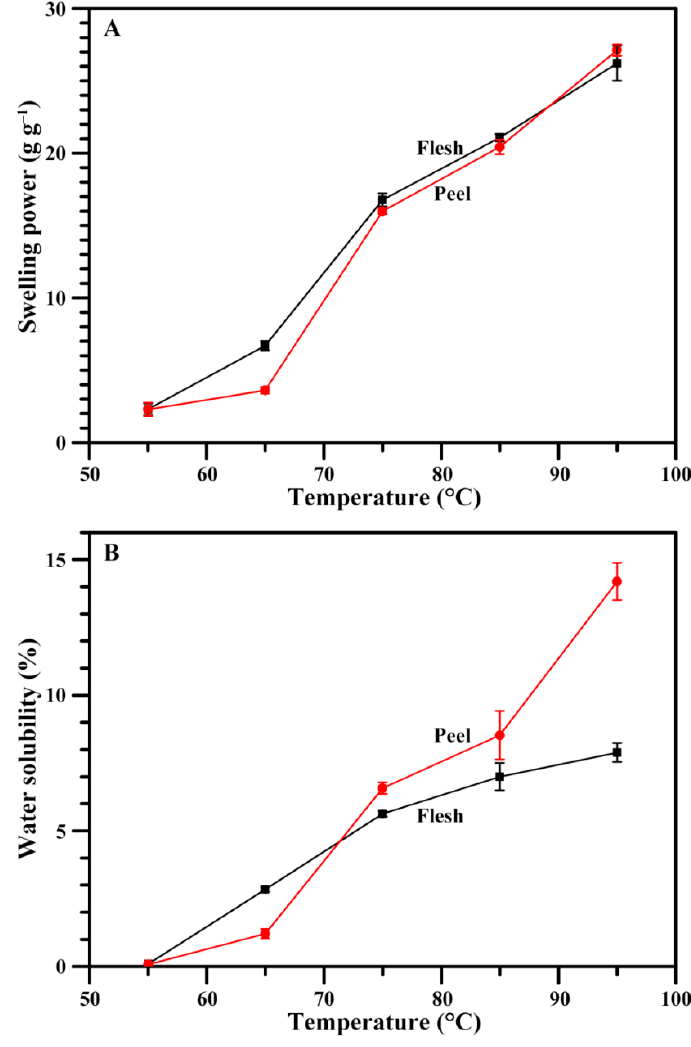
Figure 7. Swelling powers ( A ) and water solubilities ( B ) of starches.